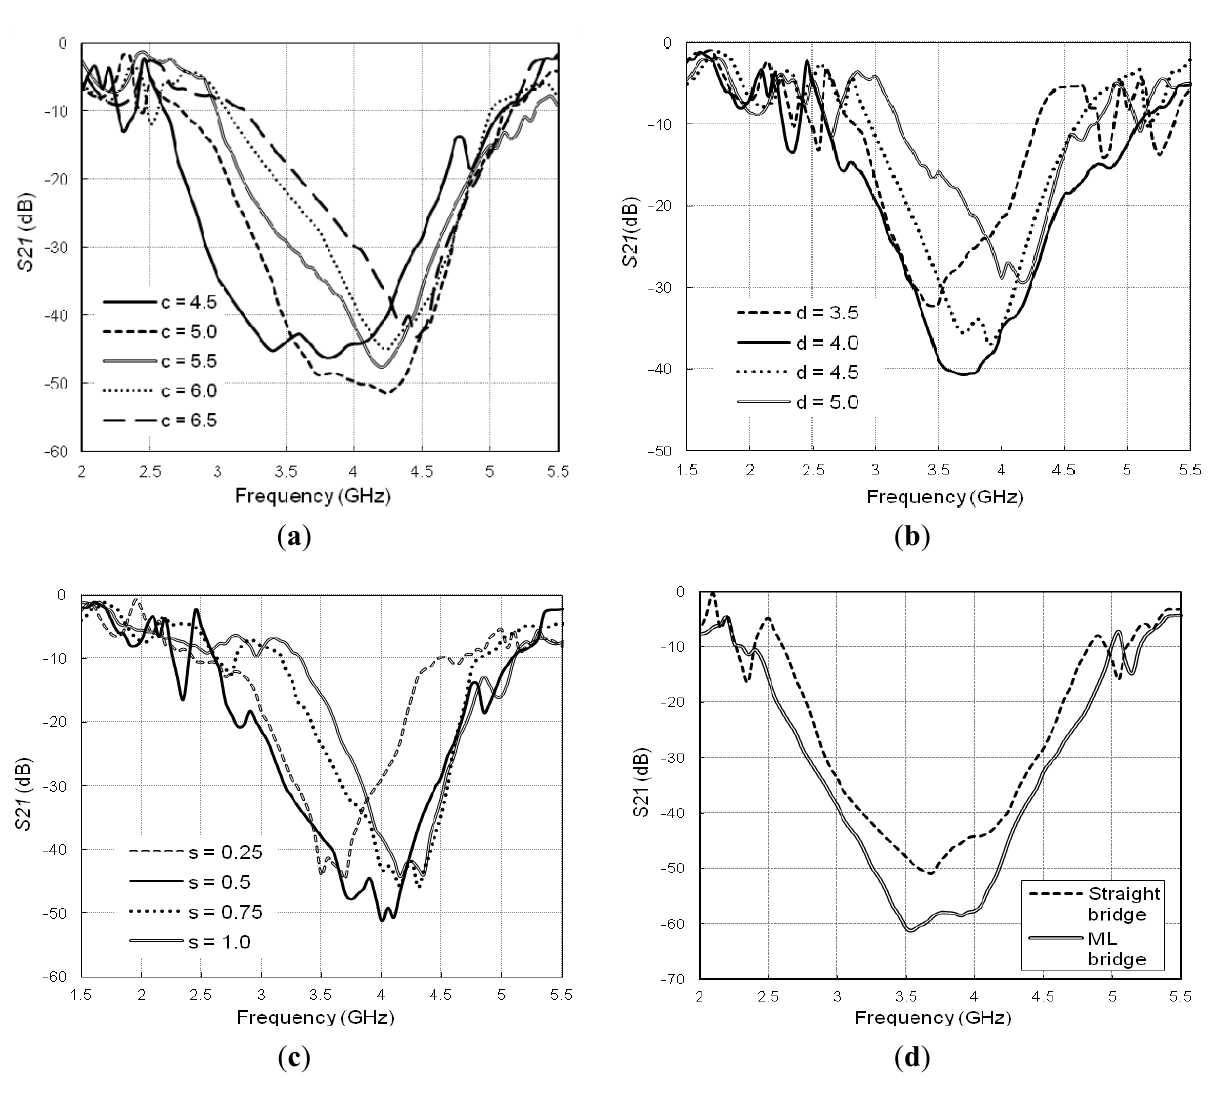
Figure 3. Transmission responses with variation of the ( a ) Centre patch size; (b )